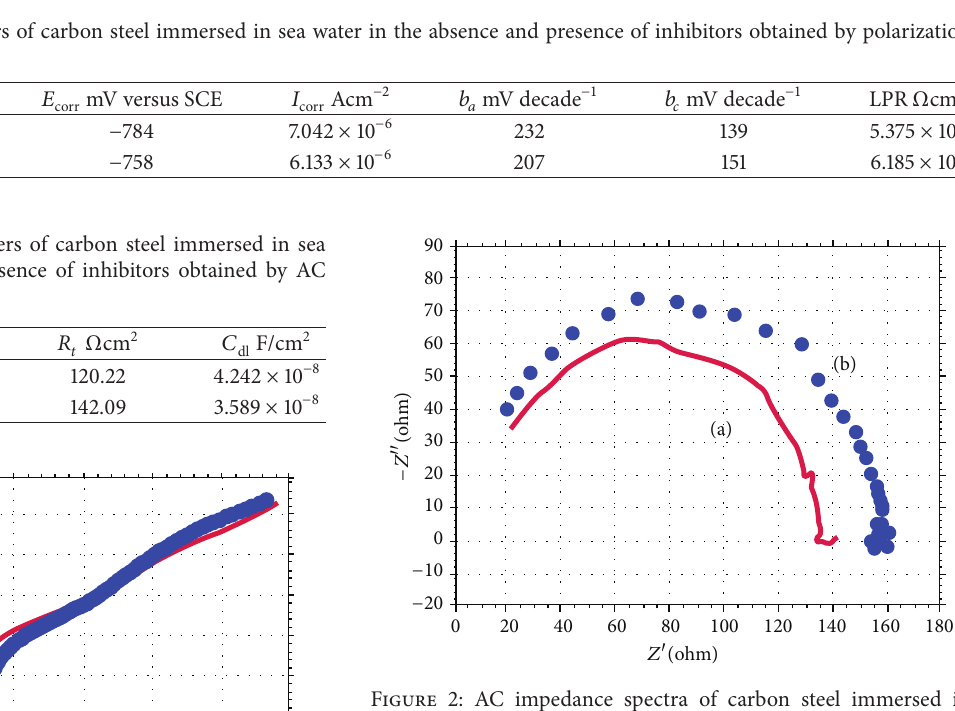
Figure 2: AC impedance spectra of carbon steel immersed in various test solutions (Nyquist plots). (a) Sea water. (b) Sea water + L-Arg (250ppm) + Zn 2+ (25ppm).